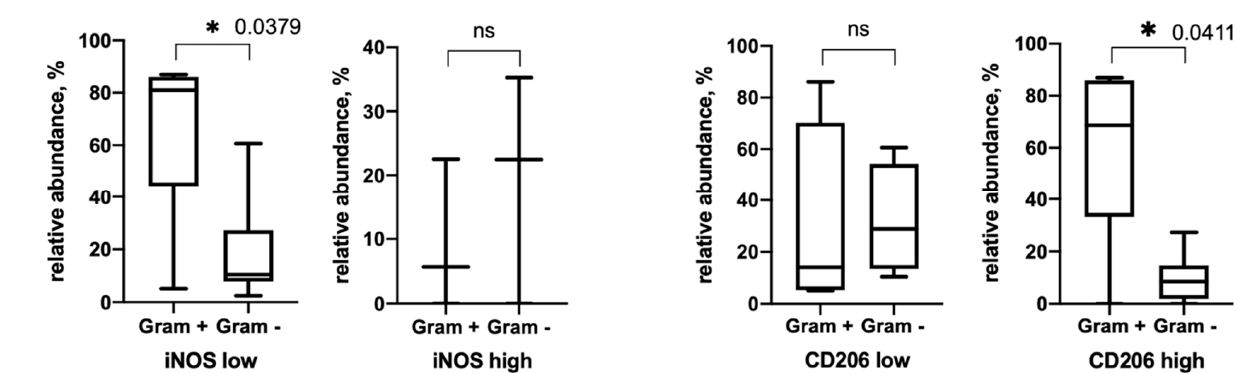
Figure 4. Relative abundances of Gram–positive and Gram–negative bacteria depending on the expression of iNOS and CD206 positive cells in esophageal tumors. * p < 0.05.